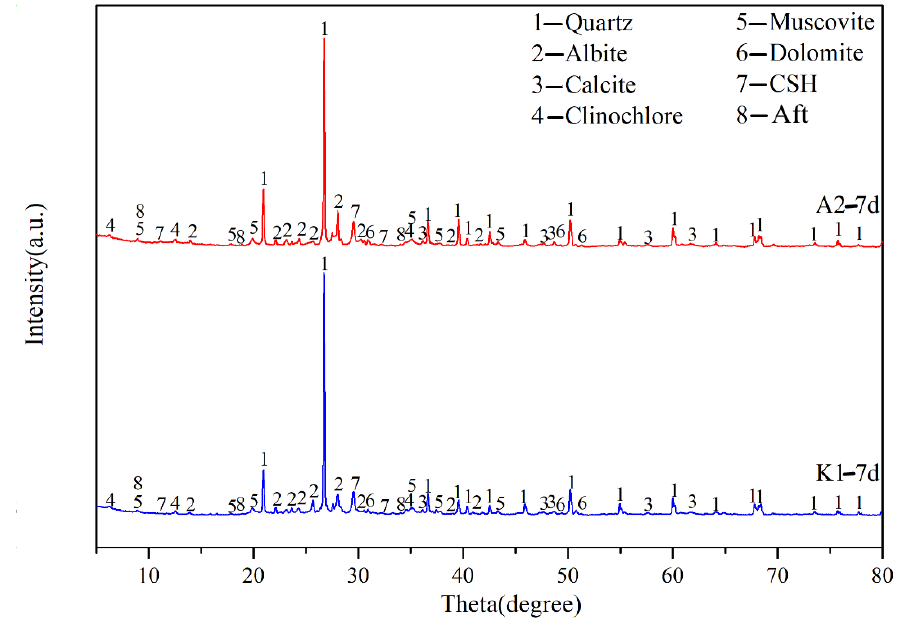
Figure 14. XRD patterns of the ordinary- and composite-cemented soil, cured for 7 d.